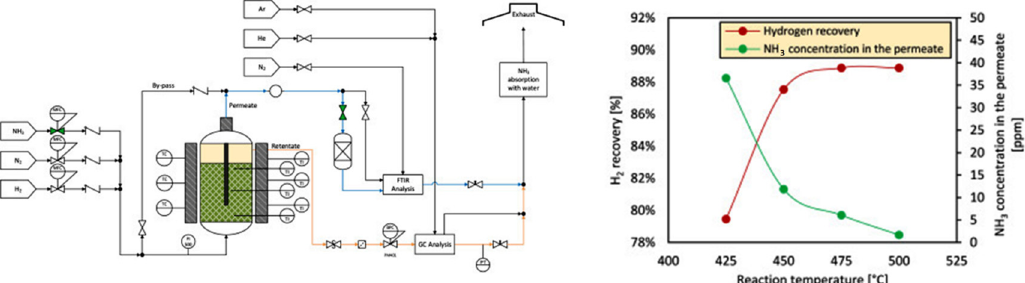
Figure 24. The effect of reaction temperature of the ammonia decomposition over a Pd-based membrane (PMR) on hydrogen recovery and ammonia concentration in the hydrogen permeate. Reprinted with permission [39].